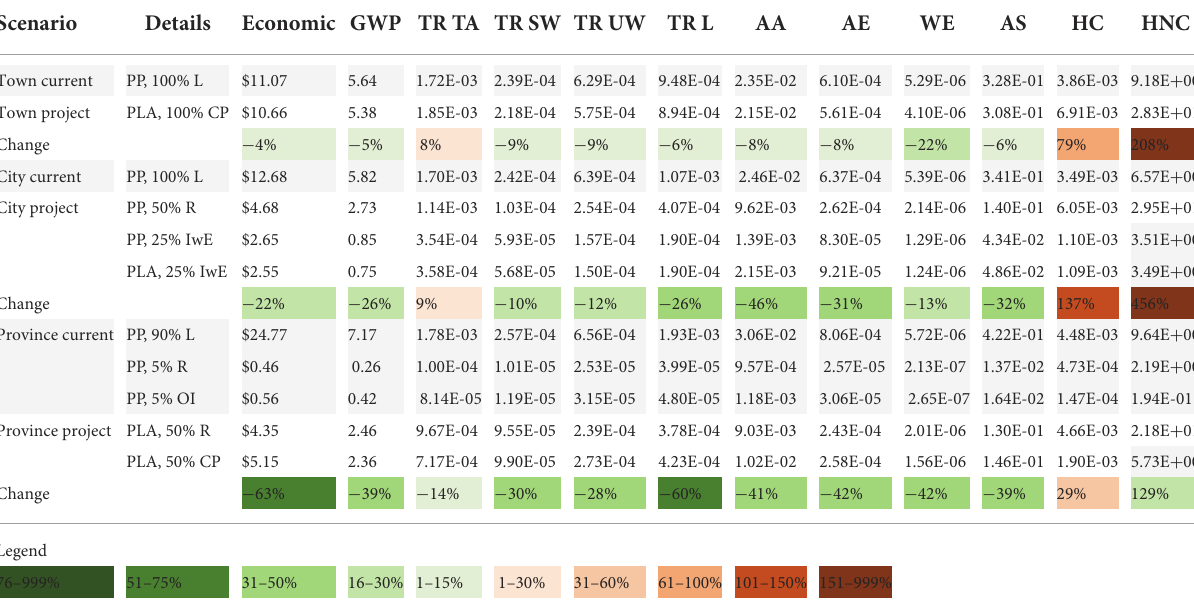
TABLE 7 Polluter pays Life Cycle Assessment